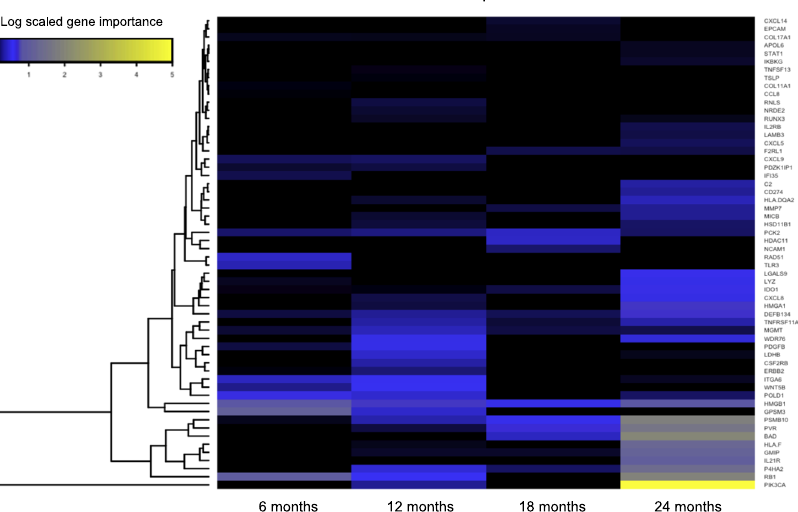
Fig. 3 Variability in the predictive value of genes across consecutive clinical bene fi t intervals. Heatmap of gene importance across time. The predictive value of certain genes varies in respect of time. A distinct set of genes appears to “ switch on ” at 24 months post treatment